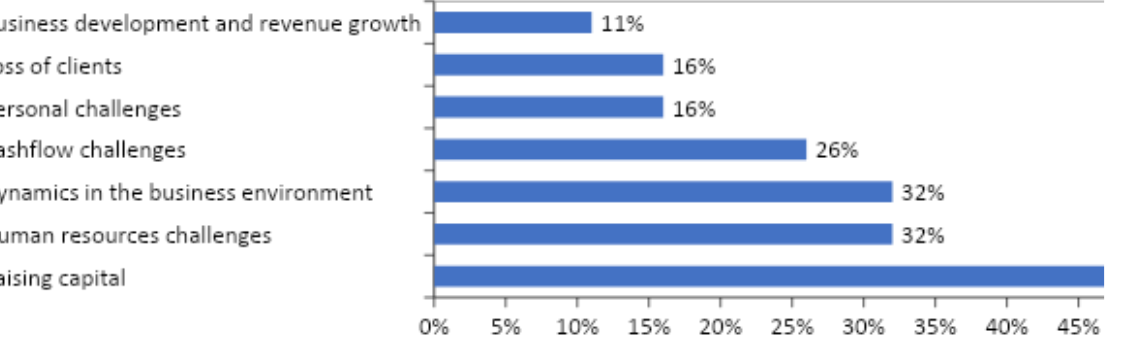
Figure 13: Challenges faced by Startups